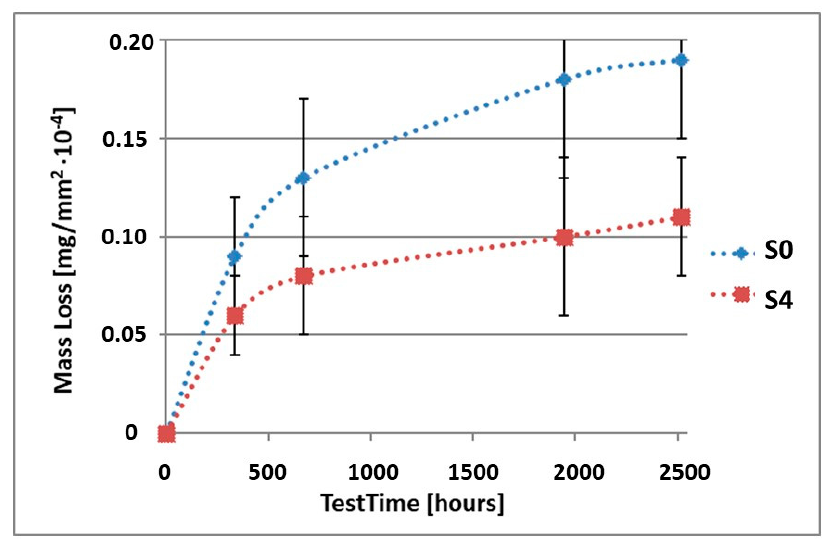
Figure 9. Comparison of the mass losses of samples S0 and S4 for tests in CASS environment.